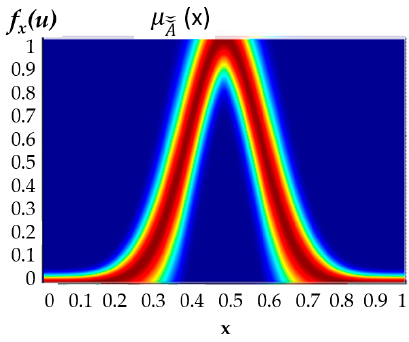
Figure 4. FOU of the Generalized Type-2 membership function.